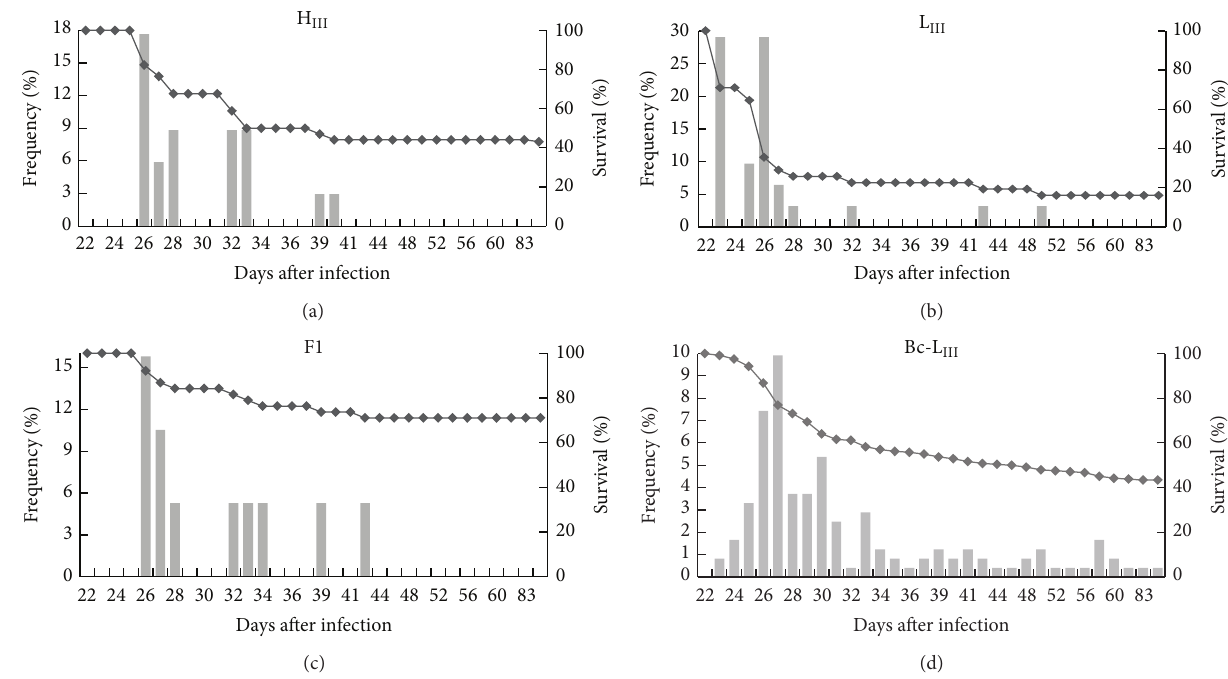
Figure 6: Survival curves and the mortality frequencies each day after T. cruzi infection. Males and females of inbred parental H III (a) and × L ) hybrids (c), and backcrossed Bc-L ( F 1× L L III (b) lines, F 1 ( H III III of the CL strain of T. cruzi and monitored daily for